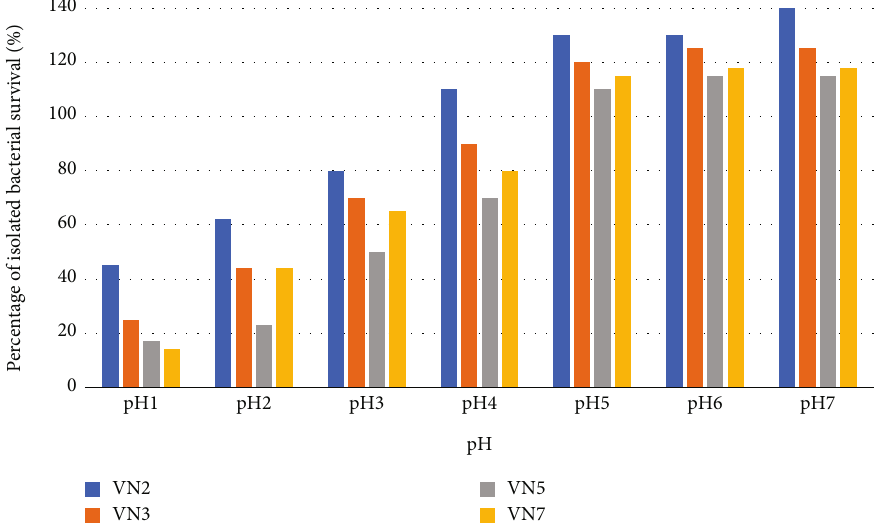
Figure 7: Acidic tolerance